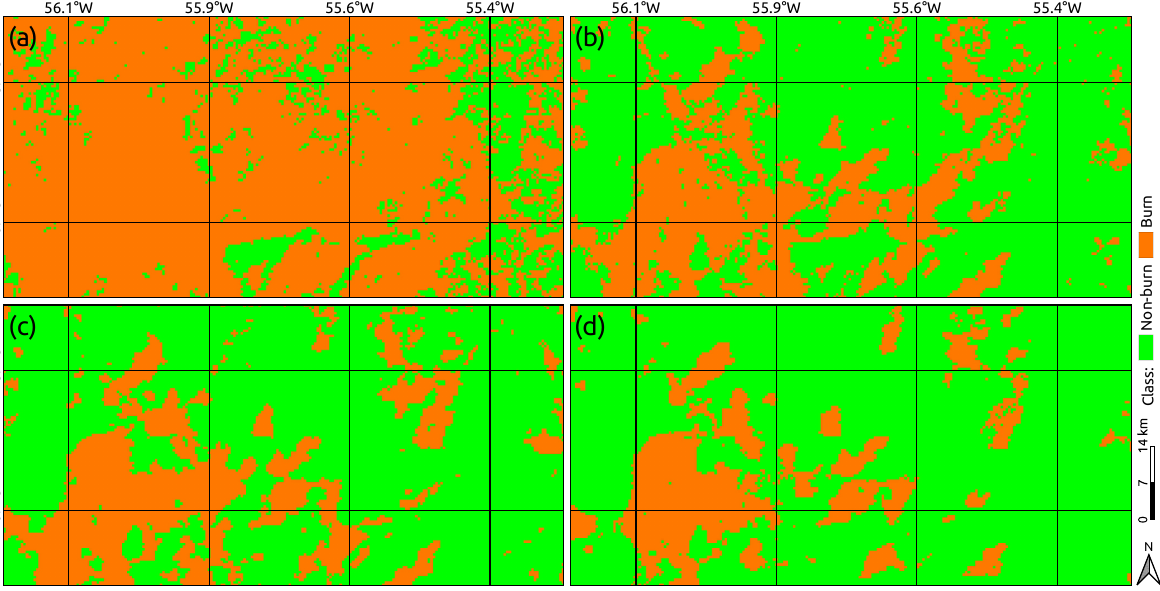
Figure 12. The mapping of fire-affected locations provided by the ( a ) MTDNBR, ( b ) GKM, and ( c ) UFD+MRF methods for Area 3 using MODIS data. Estimates from the MBA product are shown in ( d